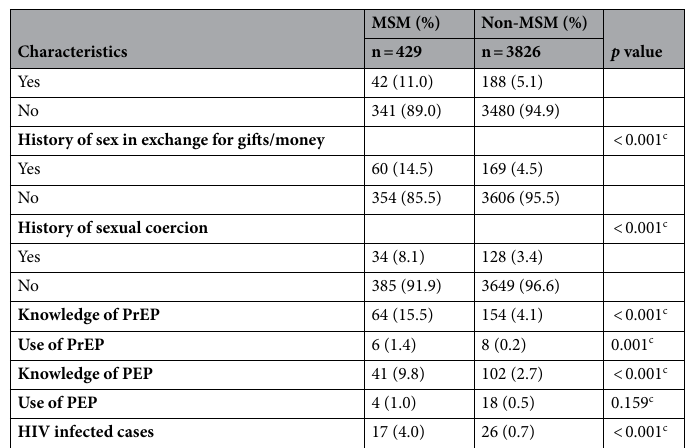
Table 2. Demographics and behavioral profiles of identified men who have sex with men (MSM) and non-MSM among the participants before induction. PrEP pre-exposure prophylaxis, PEP post-exposure prophylaxis. a p value for comparison of mean of characteristic between group (independent sample t-test). b p value for comparison of proportion of characteristics between group (Chi-square test). c p value for comparison of proportion of characteristics between group (Fisher’s exact test).